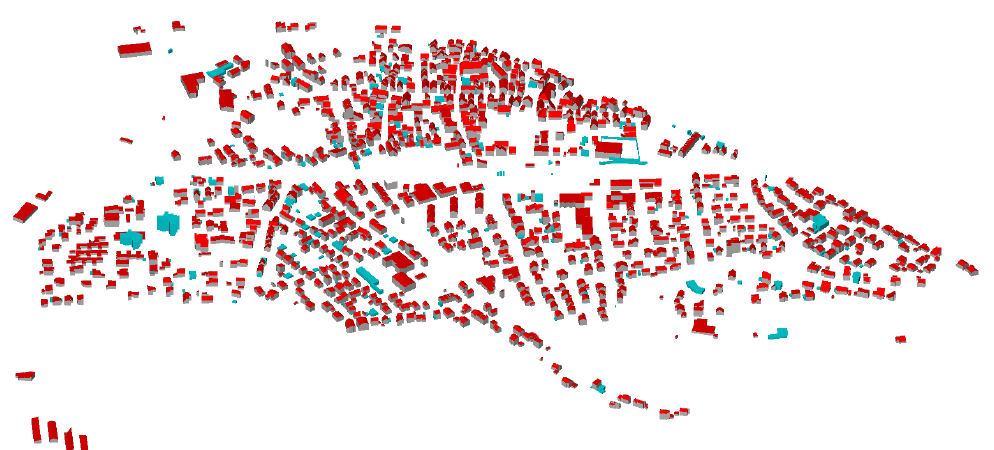
Figure 5. 3D CityGML model of the case study town of Walheim. The CityGML model was created by the State Agency for Spatial Information and Rural Development Baden-Württemberg.